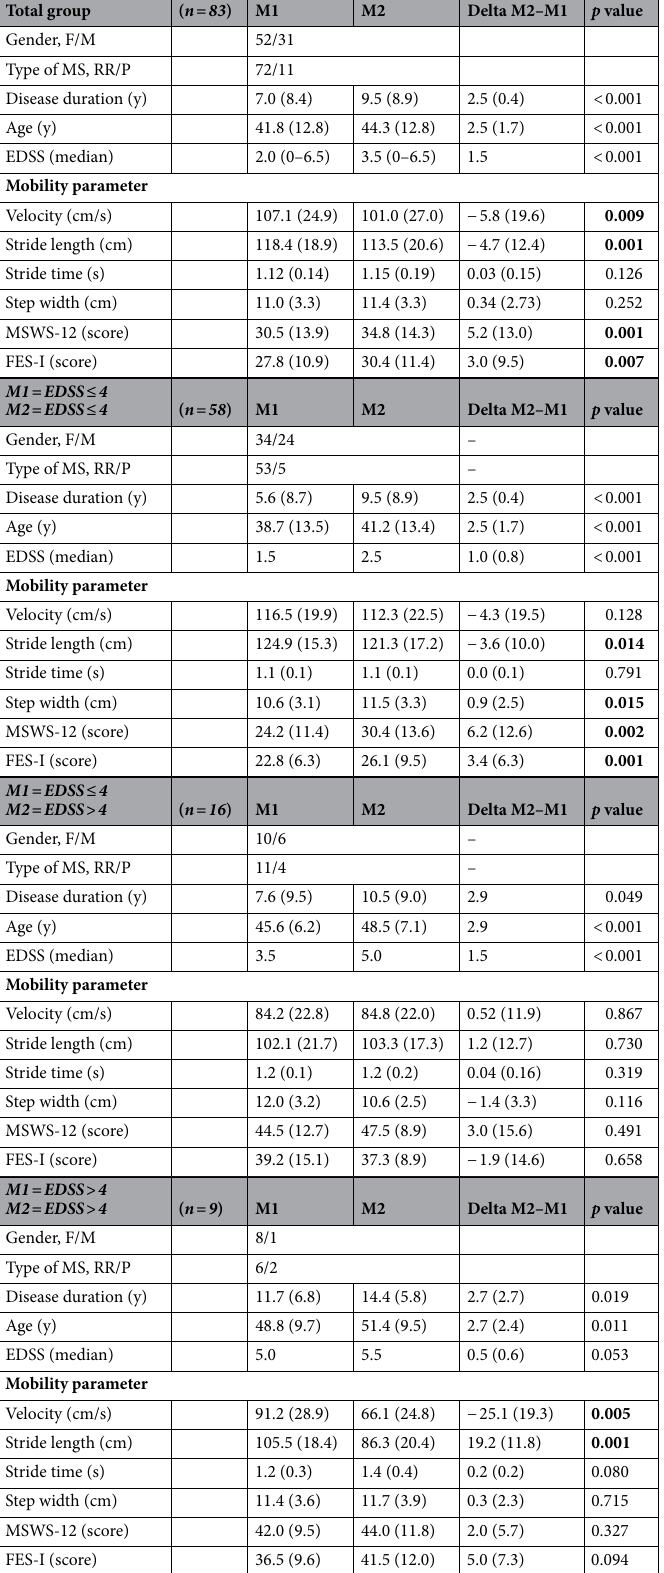
Table 1. Clinical, demographical characteristics and mobility metrics of the total sample and disability subgroups. Significant values are in